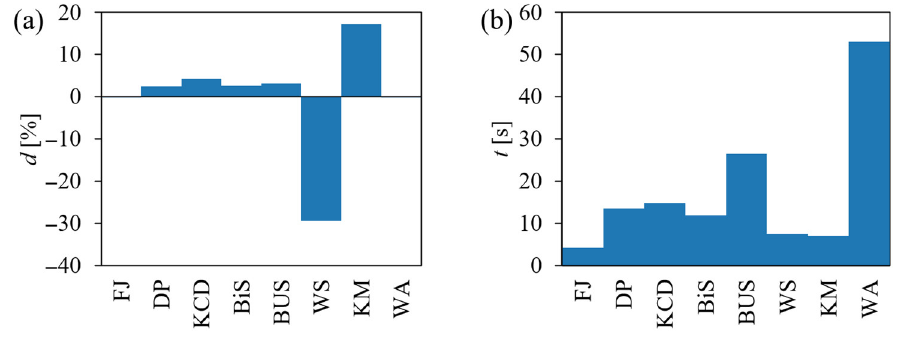
Figure 4. ( a ) Average difference ( d ) between threshold values returned by specific algorithms and the mean from all the methods, and ( b ) the mean time ( t ) of algorithm execution per 100 nodes. In the absence of a discrete breakpoint in the dataset, represented by the lower range of the FDC, all the methods showed a tendency to select a specific point in the dataset. For example, the KM algorithm tended to choose the highest value as the breakpoint, while WS generally chose the lowest value. Four algorithms (FJ, DP, KCD and BiS) tended to choose a value close to the median of the distribution. To test if the results of the breakpoint algorithms were statistically different from the medians, a T-test was run using series representing the objective threshold based on the FJ algorithm, the median, and the percentile representing the middle probability value of a given range (e.g., for a FDC range of 30% the values of Q 15 was considered the middle probability). Since all series were considered part of the same data distribution, a dependent T-test was used. The differences between the objective thresholds, median values, and middle-range flow percentiles were shown to be statistically significant, meaning the series did not result in the same values most of the time (Table 2). This shows that although the FJ method showed a tendency to define the breakpoint of the FDC as a value close to the median, the resulting Q obj remained statistically significant in its difference from the